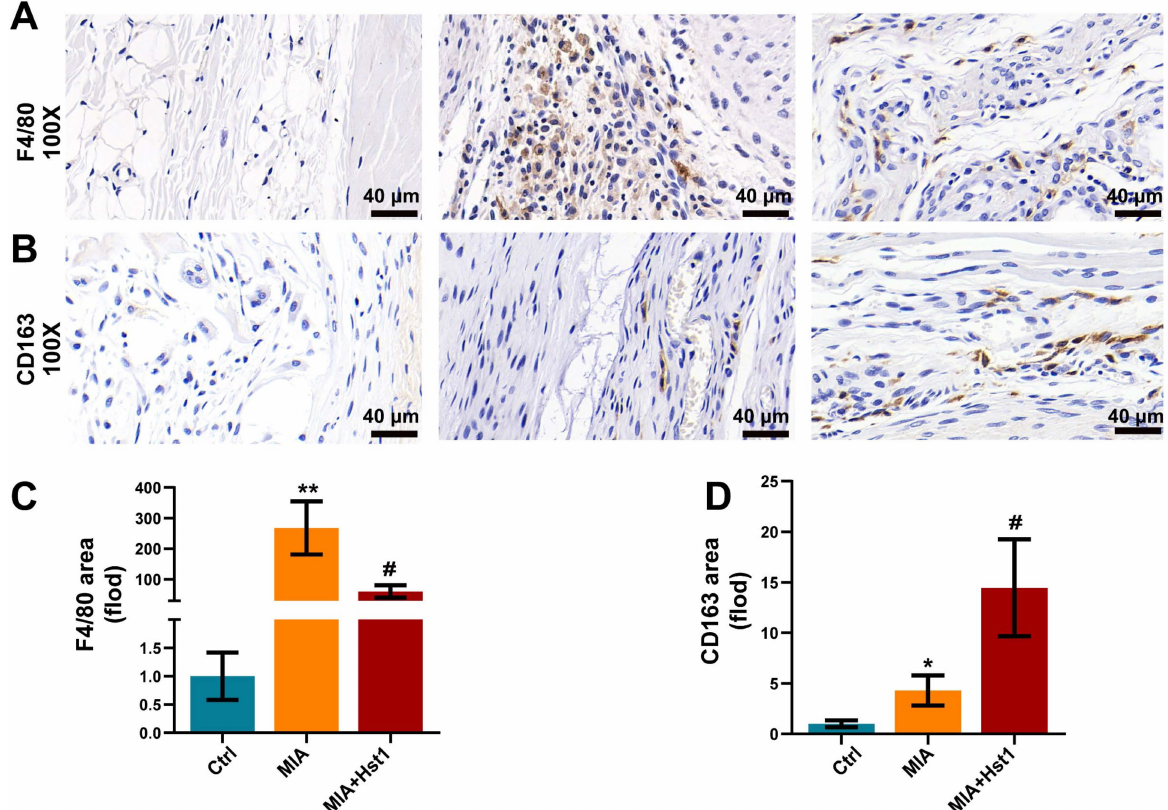
Figure 2. Hst1 reduced macrophage infiltration in the MIA-induced knee OA. ( A , B ) Synovial macrophages of the knee joint were identified by using F4/80 immunohistochemistry; more- over, CD163 was chosen for marking M2 macrophages. ( C , D ) Quantitative analysis of synovial macrophages and M2 macrophages, scale bar = 40 µ m. Data are expressed as means ± SD from three independent experiments. Significant differences compared to the control group: * p < 0.05 and ** p < 0.01, and compared to MIA group: # p <